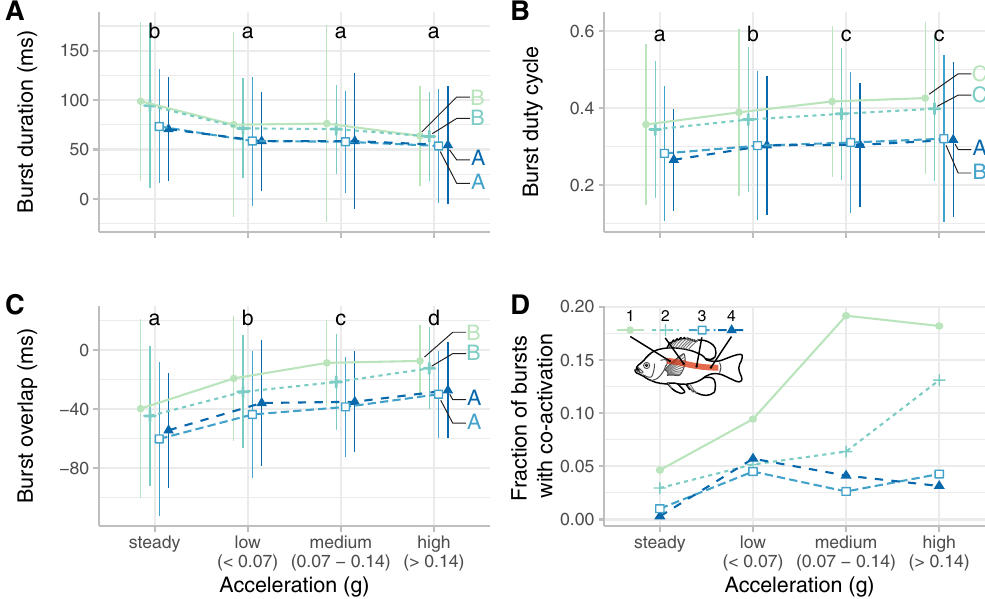
Figure 3. Bluegill sunfish ( N = 5) alter their red axial muscle activity during forward accelerations. ( A ) Burst duration decreases during acceleration and along the length of the body. ( B ) Duty cycle increases with acceleration and is higher in the anterior portion of the body. ( C ) The duration of overlap between left and right side activity increases with accelerations and is higher in the anterior body. ( D ) The fraction of bursts with co-activation (overlap greater than zero) increases with acceleration, particularly for the most anterior location. Color indicates location along the body. Acceleration groups and EMG locations labeled with different lowercase or uppercase letters, respectively, are significantly different from one another (p < 0.01). See Table S3 for statistical results.